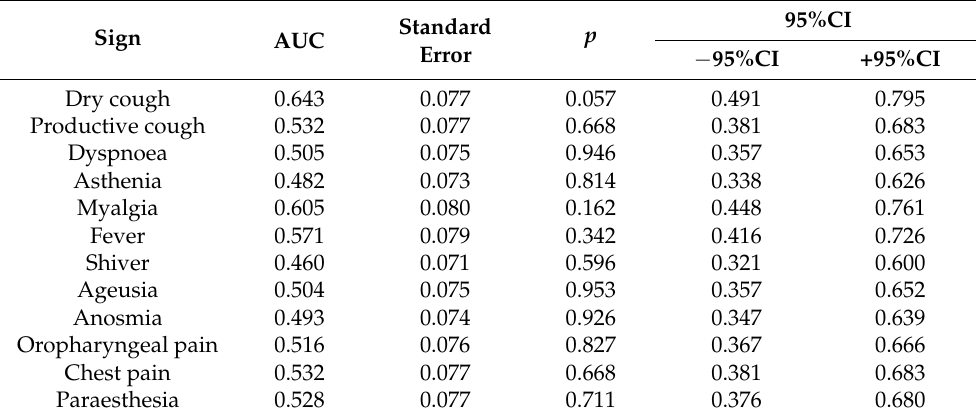
Table 9. Signs and symptoms in relation to unfavorable evolution in patients with SARS CoV-2 and pneumonia.